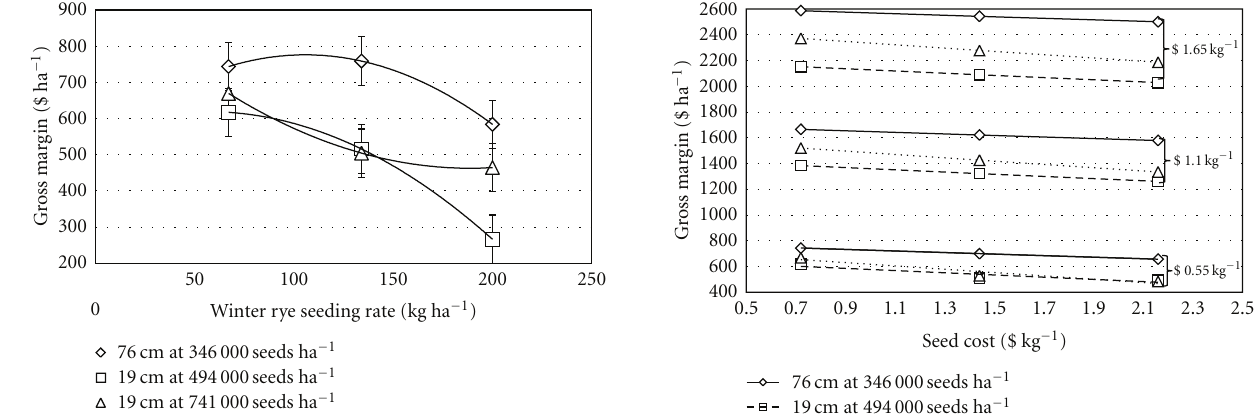
Figure 2: Gross margins for spring-interseeded winter rye rates for wide (76-cm) and narrow-row (19-cm) soybean. The gross margin was calculated as the di ff erence between gross receipts and weed management costs. Fitted lines describing seeding rates are for wide rows (open diamonds, y = − 0 . 0216 x 2 + 4 . 5697 x + 534 . 71, R 2 = 0 . 99), narrow-row low (NRL, open squares, y = − 0 . 0171 x 2 + 1 . 9141 x + 565 . 4, R 2 = 0 . 99), and narrow-row high (NRH, open triangles, y = 0 . 0139 x 2 − 5 . 2651 x + 959 . 5, R 2 = 0 . 99). The vertical bars represent the standard errors of the means. The weedy check gross margin was $367.04 ha − 1 , $461.84 ha − 1 , and $502.45 ha − 1 for wide-row, NRL, and NRH systems, respectively. LSD ( P = . 05) was $175 ha − 1 .